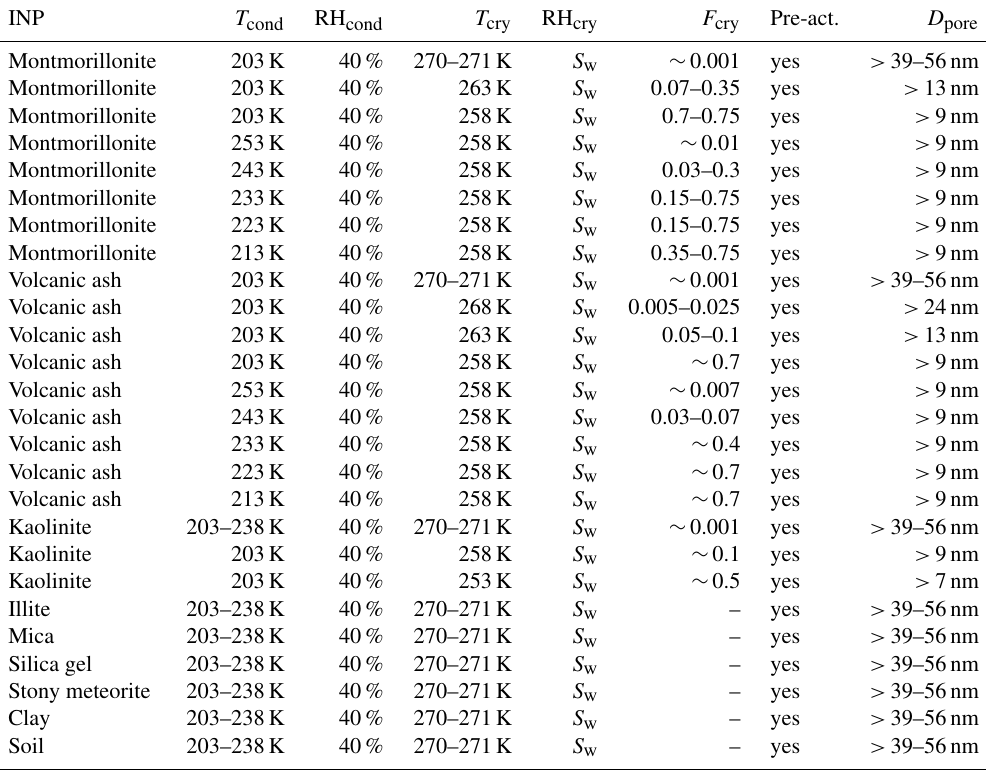
Table 5. Particles deposited on a metal foil investigated by Higuchi and Fukuta (1966); T cond – conditioning temperature; RH cond – con- ditioning RH; T cry – crystallization temperature; RH cry – crystallization RH; F cry – crystallized fraction; D pore – pore diameter needed to prevent ice from melting; S w – water